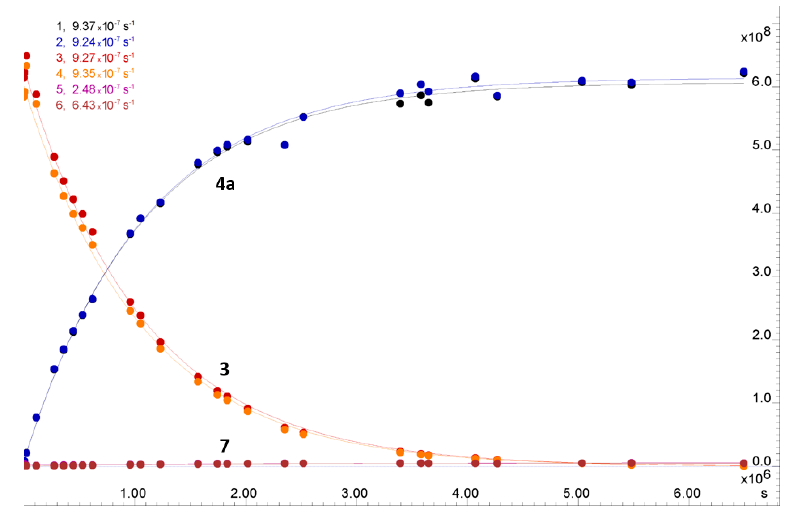
Figure 4. Imidazole region of time-dependent 1 H NMR spectra in DMSO- d 6 for the mixture of 3 , 4a, and 7 . Imidazole protons of: 3 (presented in orange and red), 7 (presented in green and grey) and 4a (presented in black and blue).